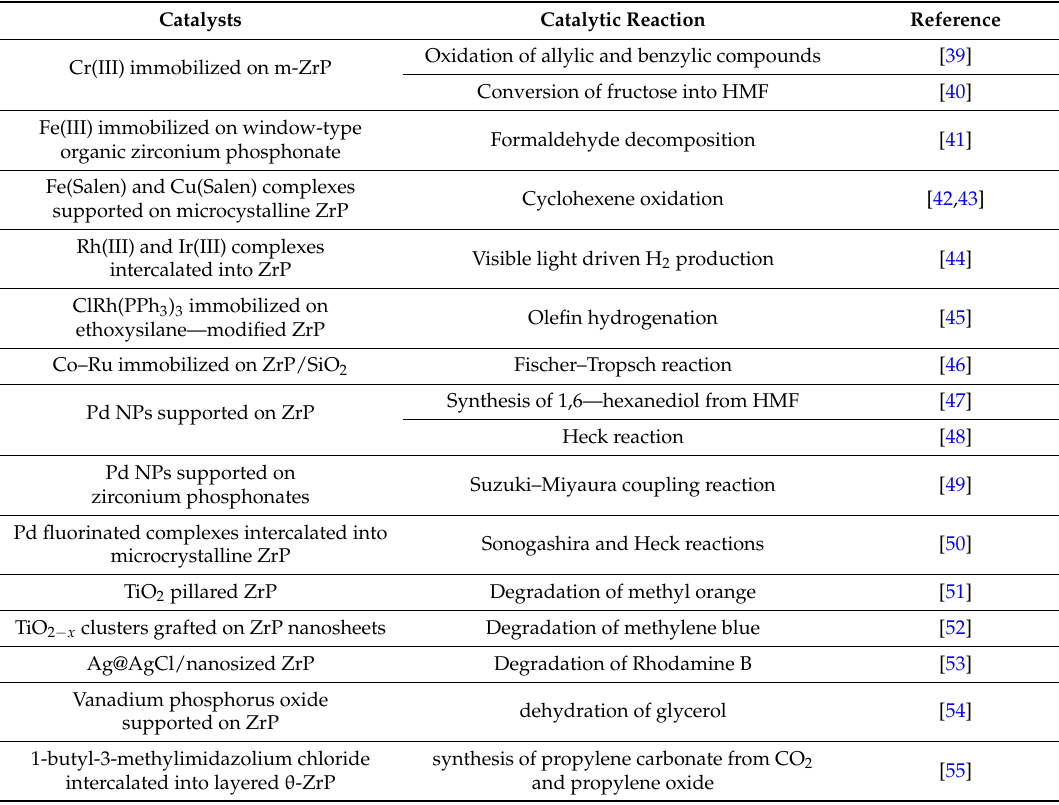
Table 2. Summarizing table on the use of zirconium phosphates and its organic derivatives as solid supports for catalytically active